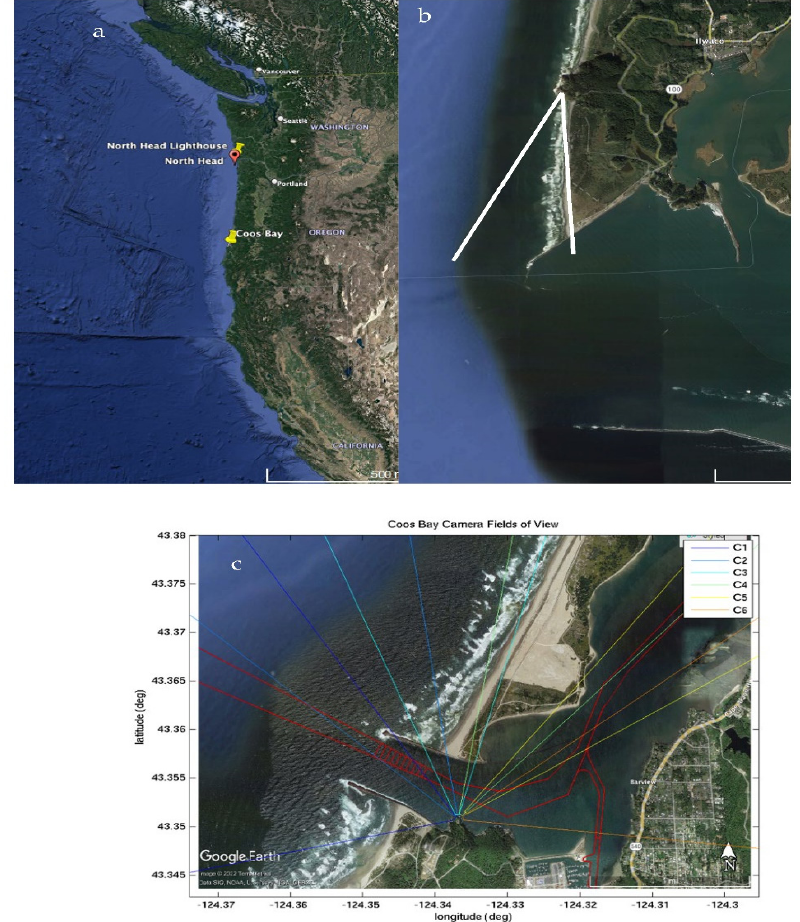
Figure 1. Map views of the two field sites. ( a ) Shows the entire Pacific Northwest region and the locations of both North Head and Coos Bay. ( b ) Zooms in to the North Head region showing the imaged field of view to the south (white lines) spanning Benson Beach which lies between the Head and the north jetty of the Columbia River. ( c ) Shows a magnified view of Coos Bay including the two jetties, the navigation channels (in red), and the fields of view of the six Argus cameras (paired colored